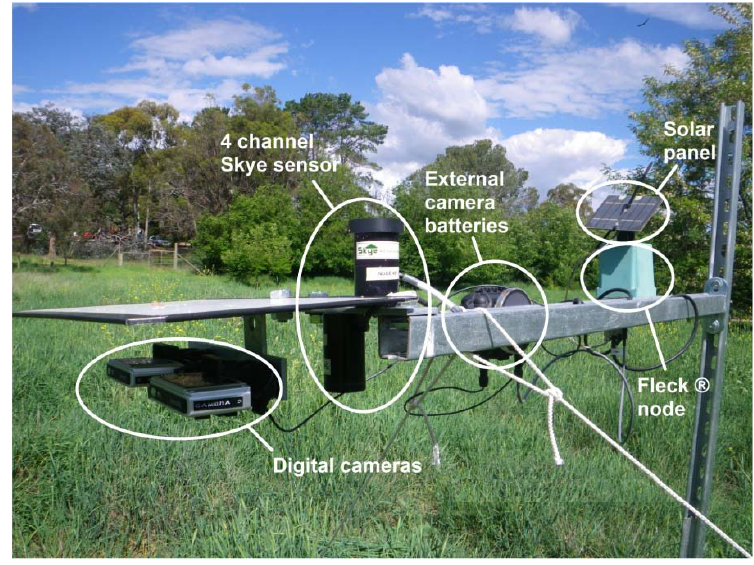
Figure 1. Node with solar powered Fleck ® , paired multispectral sensors and digital cameras. Note the cosine diffusion filter is fitted to only the upward-pointing